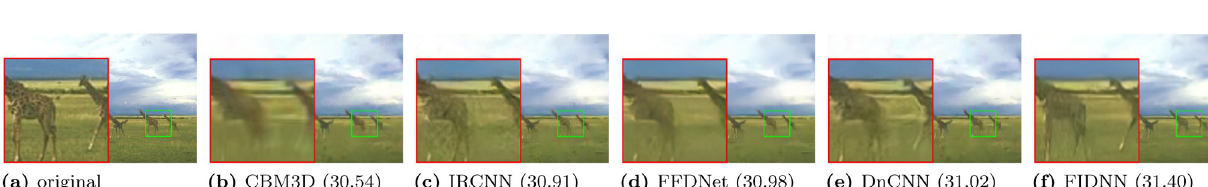
Fig 3. Gray image denoising results for noise level 50 on ‘Parrot’ image from Set12 dataset. (a) original. (b) BM3D (25.90). (c) TNRD (26.09). (d) IRCNN (26.48). (e) DPDNN (26.47). (f) FIDNN (26.67).